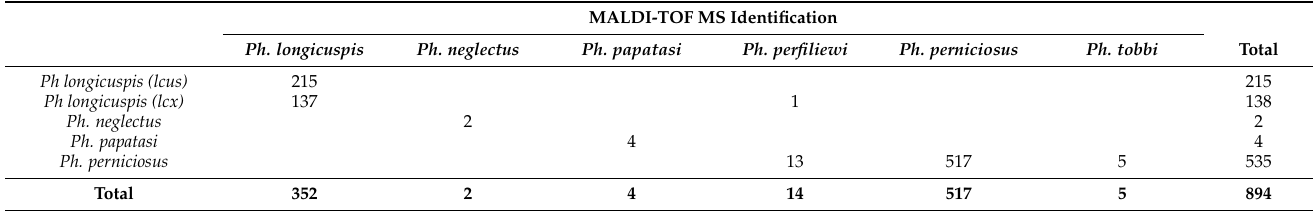
Table 3. Results of blind test using Marseille database (LSV cut-off value > 1.7). MALDI-TOF MS